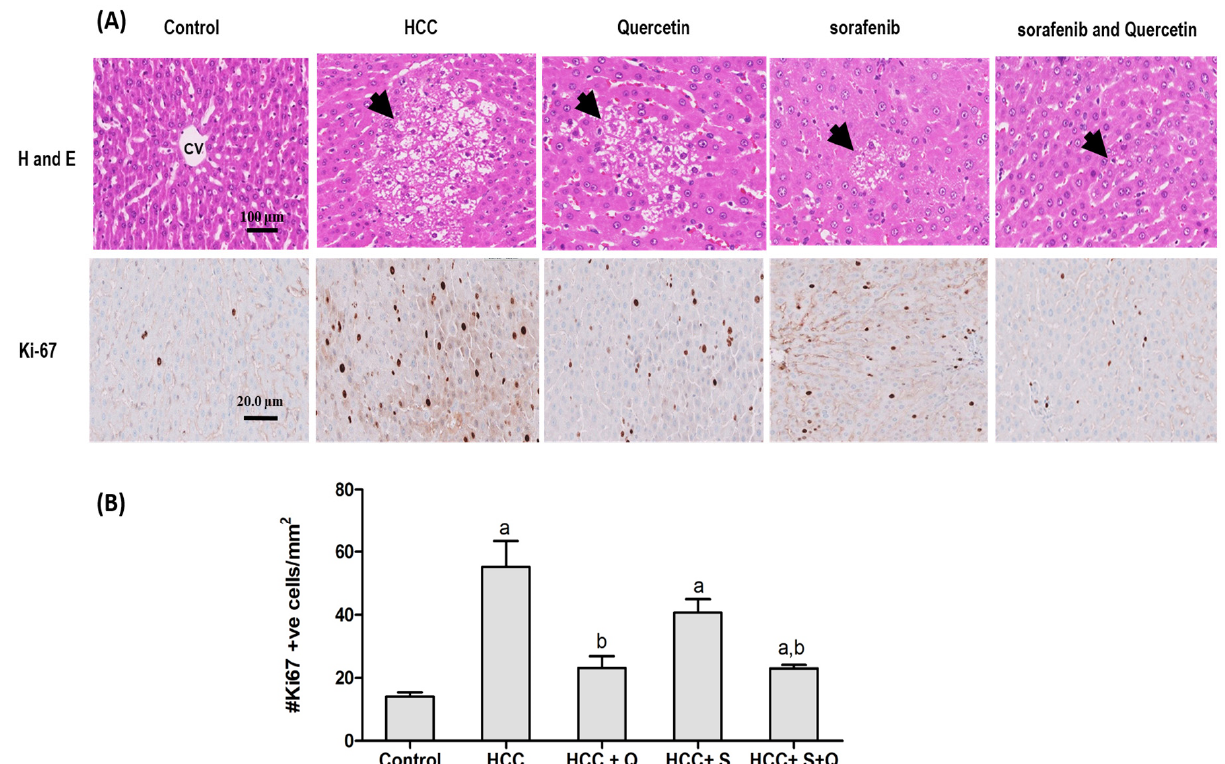
Figure 7. ( A ) Anti-tumor effect of anti-cancer treatments. Representative images of hematoxylin and eosin-stained (H and E) and Ki-67-stained sections of animals’ liver tissues are presented. The control corresponds to normal rats’ liver tissue. HCC is the HCC-induced group. HCC + Q, HCC + S and HCC + S + Q correspond to HCC rats treated with quercetin, sorafenib or a quercetin/sorafenib combination, respectively. Representative areas of tumor nodules and tumor cells are indicated by arrows. ( B ) shows the quantitative analysis of Ki-67 immunoreactive cells in 10 fields of each section of the Ki-67 positive foci and quantitative region analysis of the Ki-67–positive foci × 100 magnification (Scale bar 20 × m). The values were evaluated by one-way ANOVA followed by Dunnett’s t -test compared to the HCC induced group. Data are represented as mean ± SEM. The letter (a) is used for p < 0.05 vs. control group and the letter (b) is used for p < 0.05 vs. HCC group.